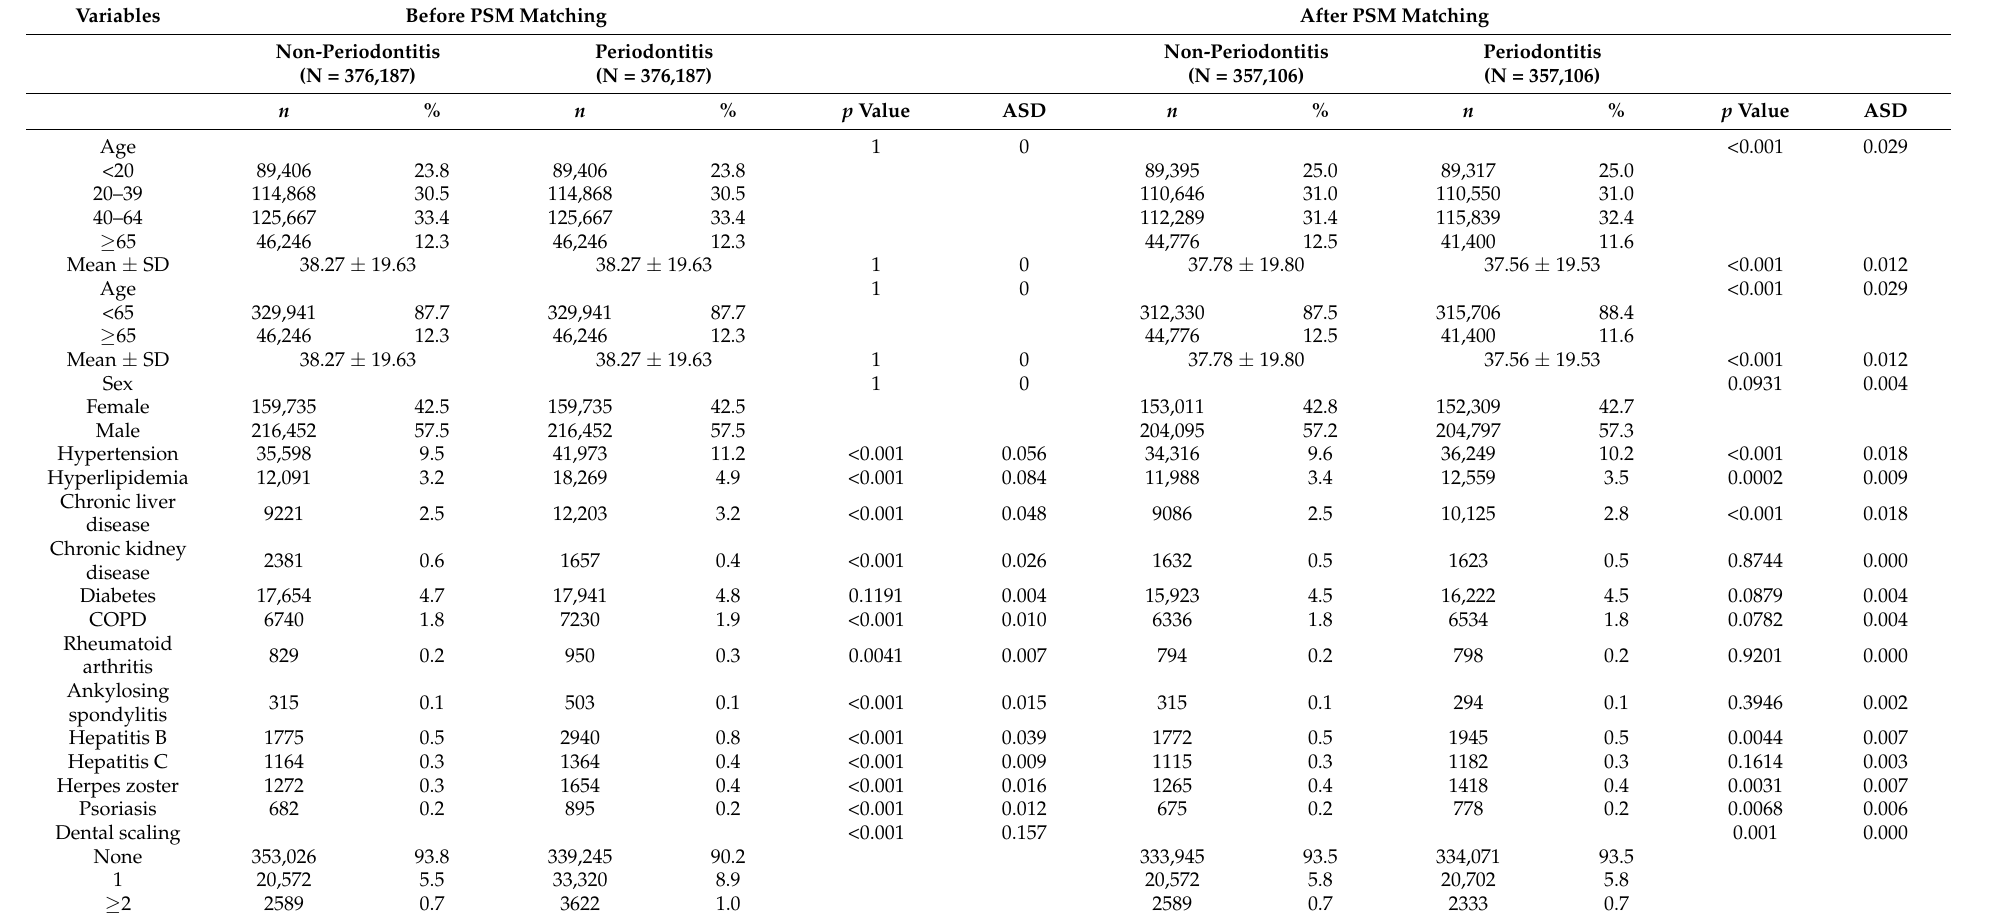
Table 1. Demographic characteristics of periodontitis and